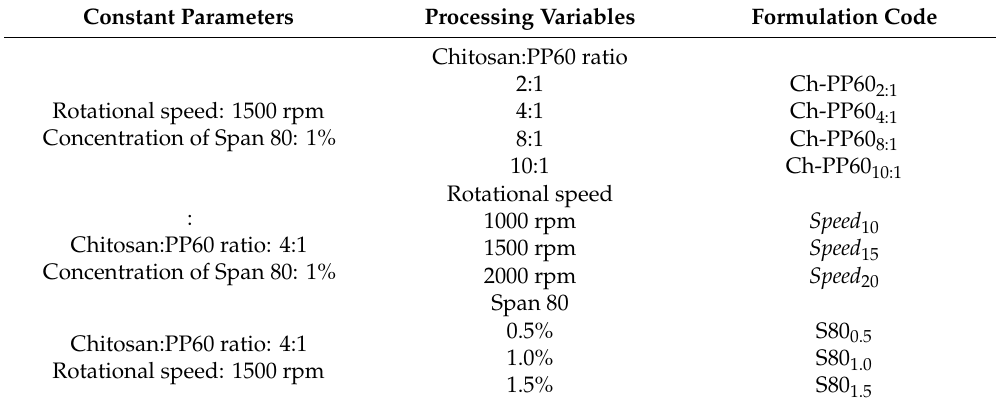
Table 1. Variable parameters of chitosan microspheres produced by emulsion cross-linking method (PP60, polyphenon 60; rpm, rotations per minute; % ( w / v ), percentage weight per volume). Processing Variables Formulation